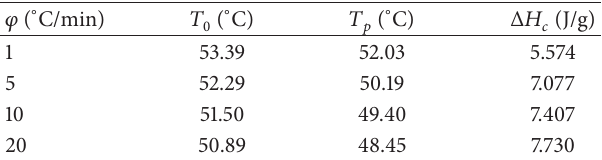
Table 3: Values of 𝐹 (𝑇) and 𝑎 for crystallization of MAG organogels at the given degree of